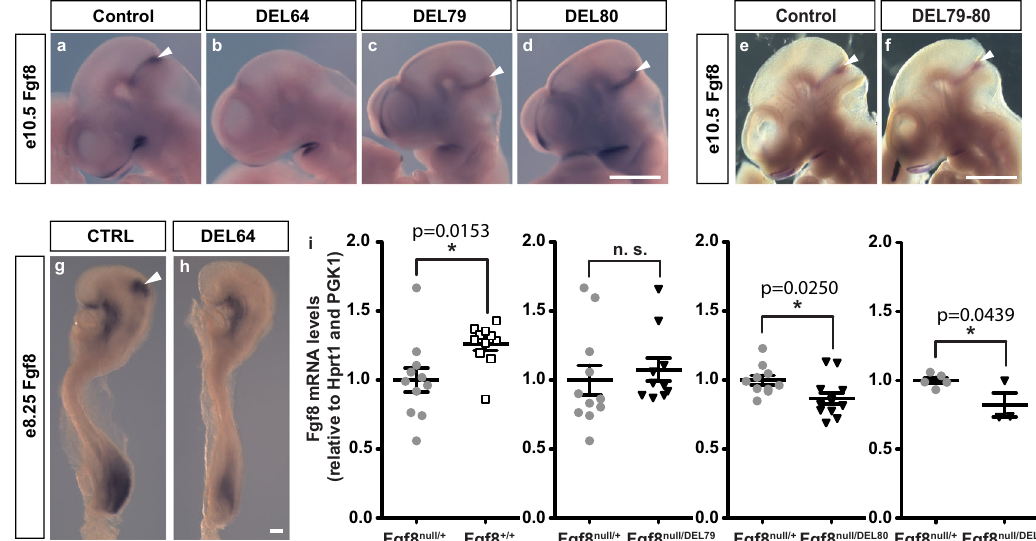
Fig. 3 CE64 is required and suf fi cient for initiation and maintenance of Fgf8 expression in the MHB. a – f In situ hybridization against Fgf8 mRNA in e10.5 embryos from control ( a , e ), DEL64 ( b ), DEL79 ( c ), DEL80 ( d ) and DEL79-80 ( f ) mutants ( n > 3 for all experimental groups). Note the complete lack of Fgf8 expression in the MHB of DEL64 ( b ) embryos as compared to controls ( a ). Brain tissue is markedly reduced already at this stage in DEL64 embryos ( b ). g , h In situ hybridization of control and DEL64 enhancer deletion embryos at e8.25 with riboprobe against Fgf8 . No expression is detected in the DEL64 embryos ( n = 4). i Relative expression of Fgf8 mRNA levels in dissected MHB region from WT ( n = 11), DEL79 ( n = 10), DEL80 ( n = 12), and DEL79-80 ( n = 3) e10.5 embryos as compared to Fgf8 null/ + ( n = 11, 11, 10, 5) control littermates. Individual data points, mean ± SEM are indicated. * p < 0.05, n.s. = not signi fi cant (two-tailed Student ’ s t -test; exact p -values are indicated in the fi gure panel). Scale bar is 1 mm in ( a – f ) and 100 μ m in ( g , h